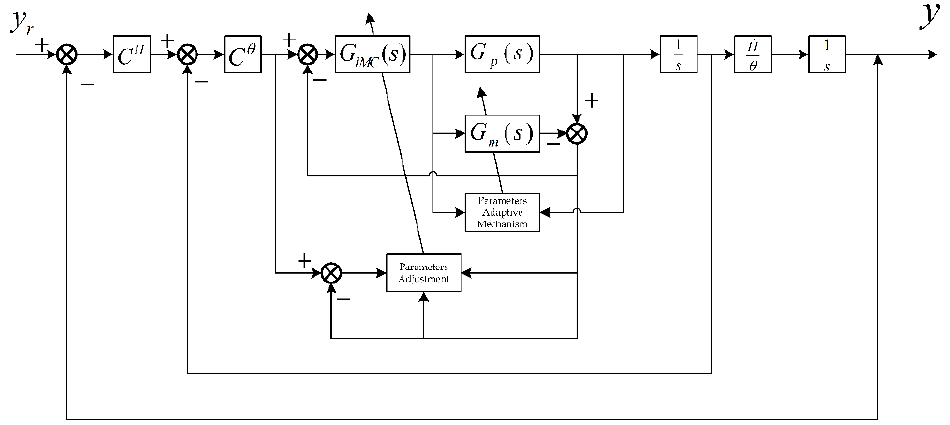
Figure 3. Design of adaptive internal model control structure based on parameter adaptation.